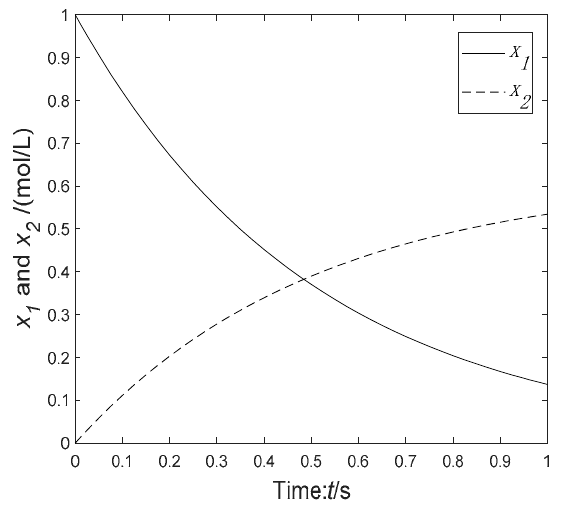
Figure 8. Optimal temperature control trajectory ( N = 40).